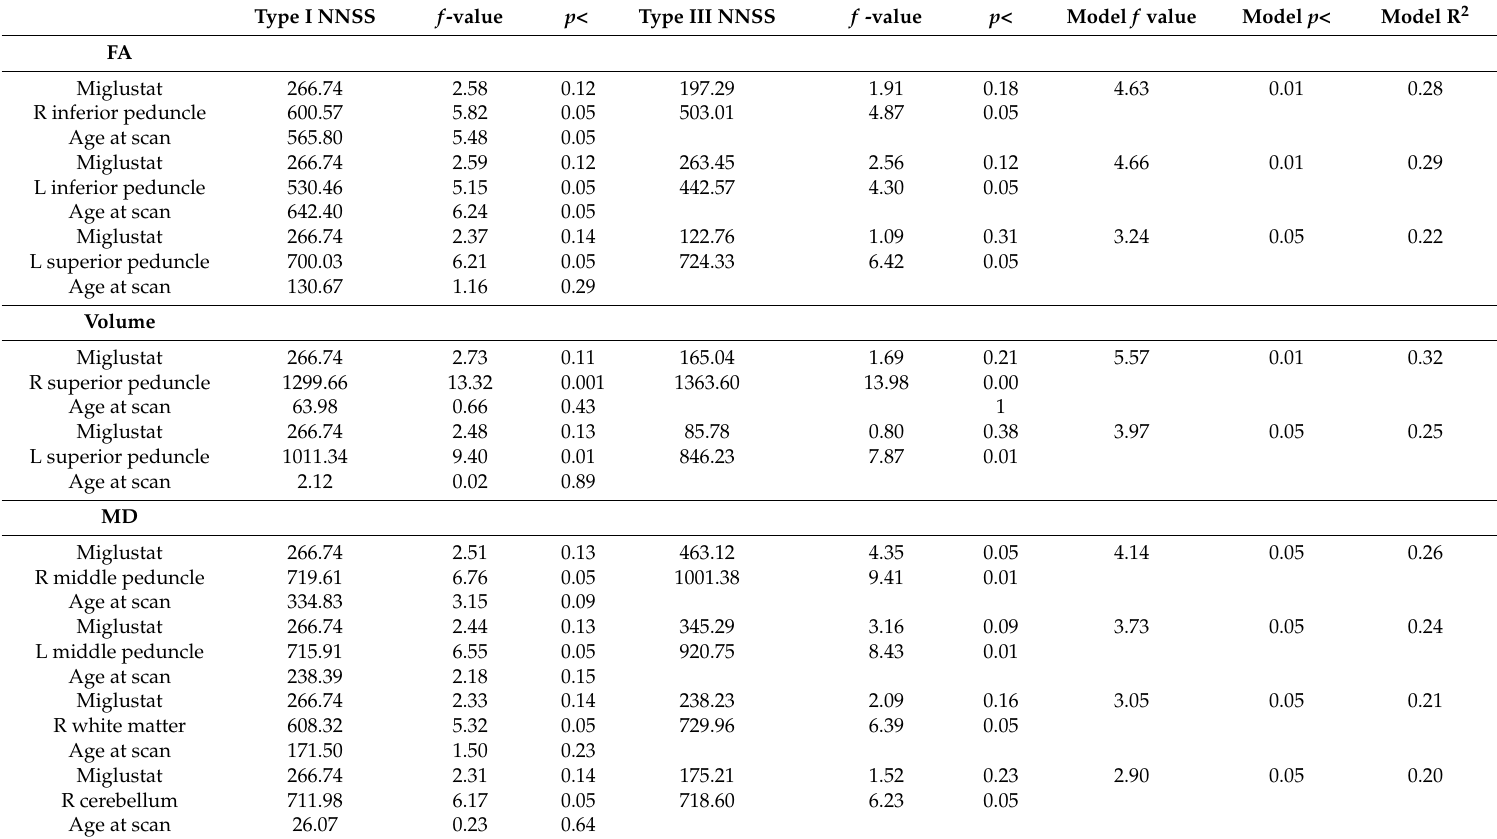
Table 6. ANCOVA of NNSS and Subcores, Miglustat and Cerebellar